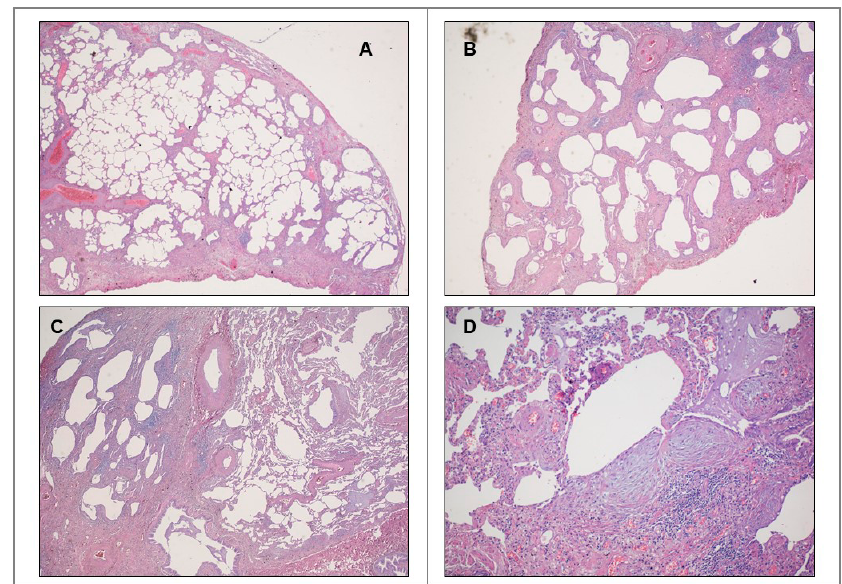
Figure 1. Histopathologic patterns of usual interstitial pneumonias. ( A ) Evidence of marked fibrosis/architectural distortion in a predominantly subpleural/paraseptal distribution. ( B ) Evidence of microscopic honeycombing. ( C ) Presence of patchy involvement of lung parenchyma by fibrosis (spatial heterogeneity). ( D ) Presence of fibroblast foci (temporal heterogeneity). Their detection allows UIP diagnosis confirmation.